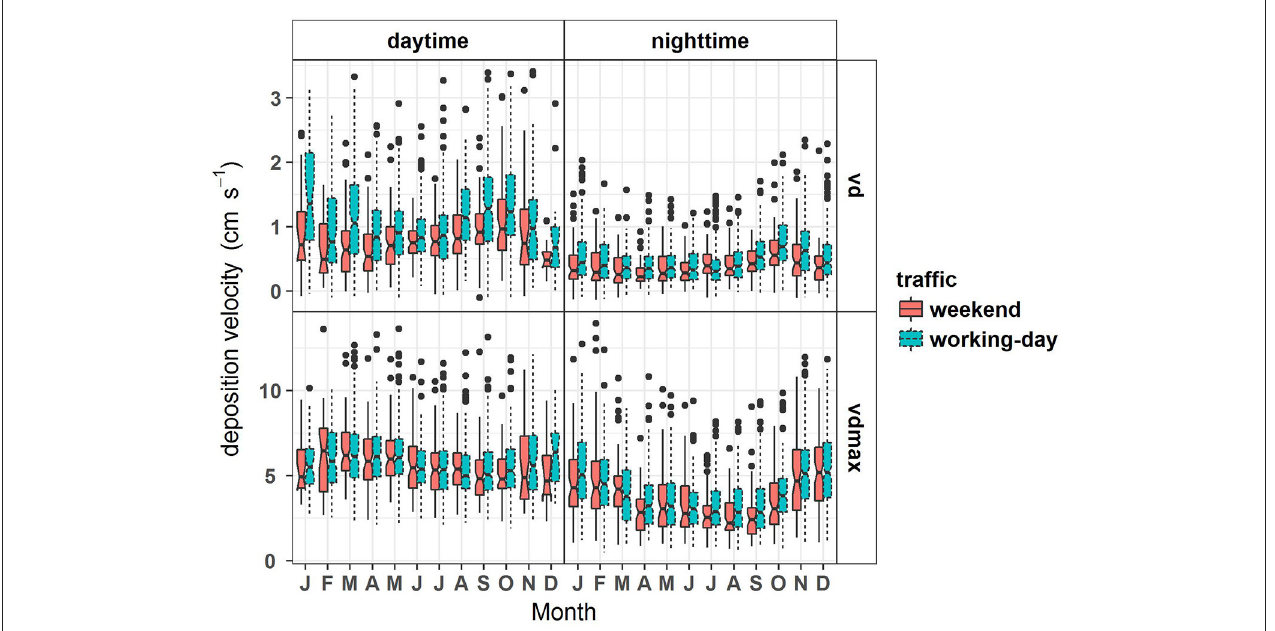
FIGURE 4 | Annual pattern of daily deposition velocity ( υ d ) and daily maximum deposition velocity allowed by turbulence ( υ dmax ) for weekends and working-days during daytime/nighttime from April 2005 till December 2015 (in cm s − 1 ). The box shows the interquartile range (IQR) of the daily υ d or υ dmax for a given month. The whiskers add 1.5 times the IQR to the 75 percentile and subtract 1.5 times the IQR from the 25 percentile. The “Notch” displays the confidence interval around the median which is normally based on the